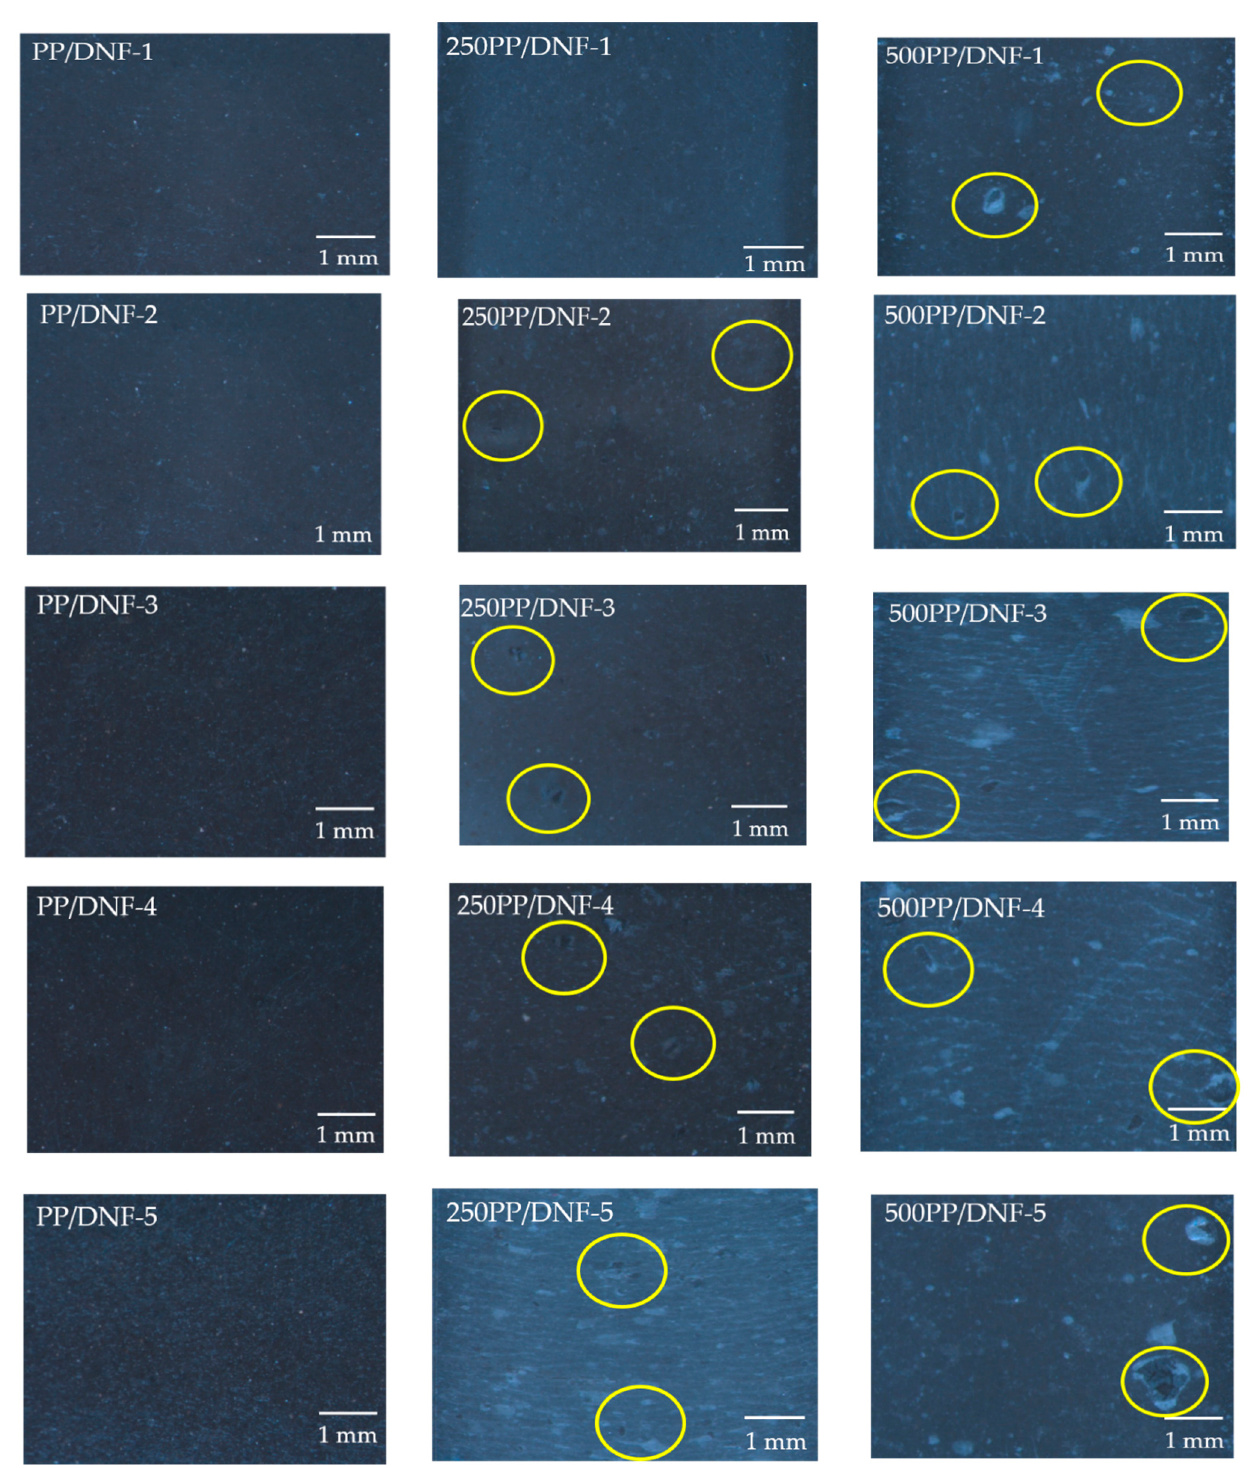
Figure 6. Microscopic surface observations by polarized microscopy (POM).